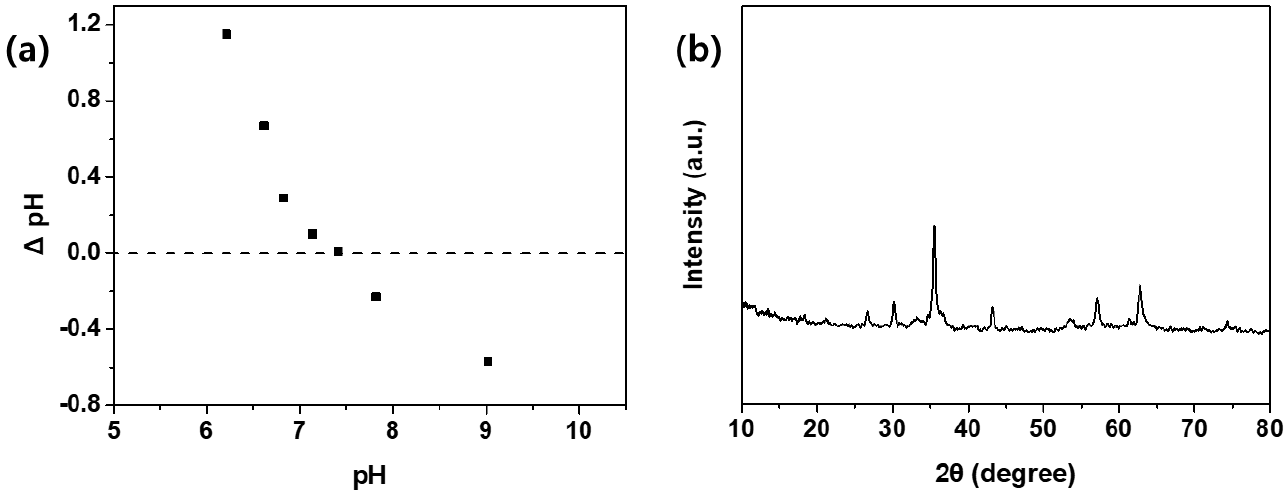
Figure 1. ( a ) pH pzc measurement and ( b ) X-ray diffraction pattern of prepared hand-warmer waste catalyst.